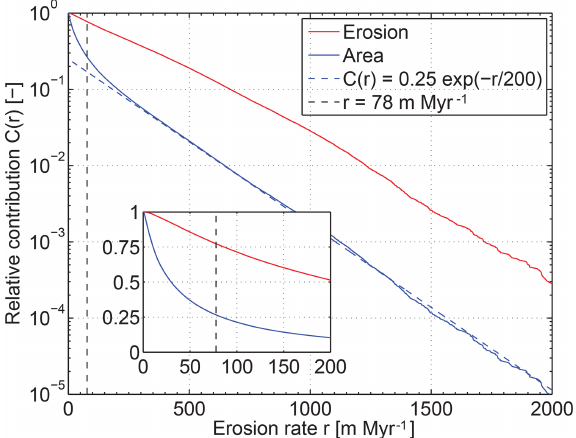
Figure 6. Cumulative distribution of the erosion rates and their con- tribution to total erosion. The blue curve shows the contribution of the part of the land surface with an erosion rate greater than r to the total area, and the red curve its contribution to total erosion.